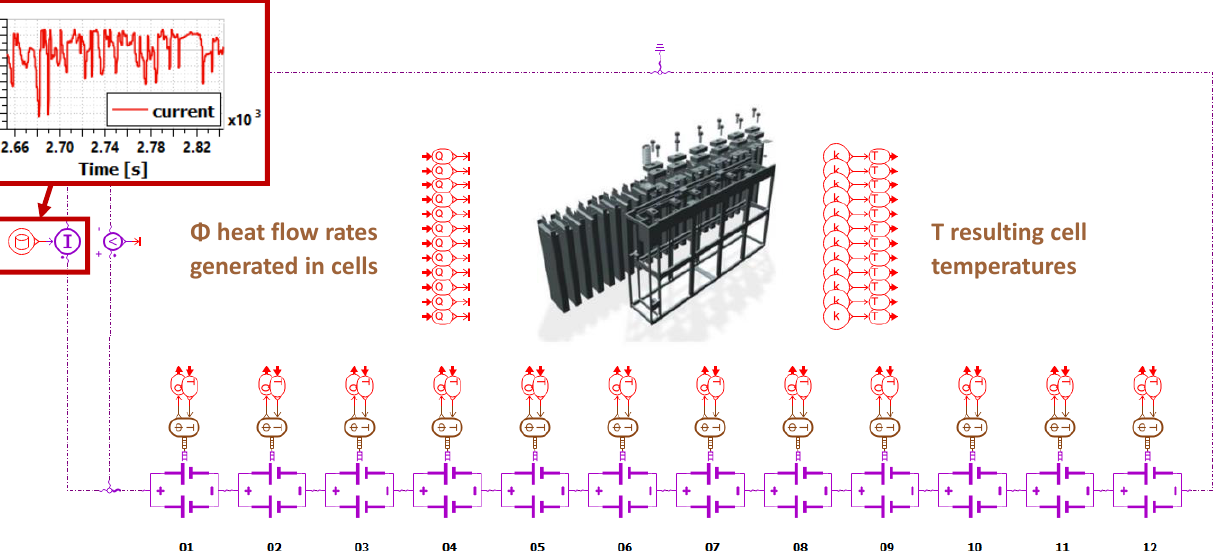
Figure 6. System simulation battery stack model.